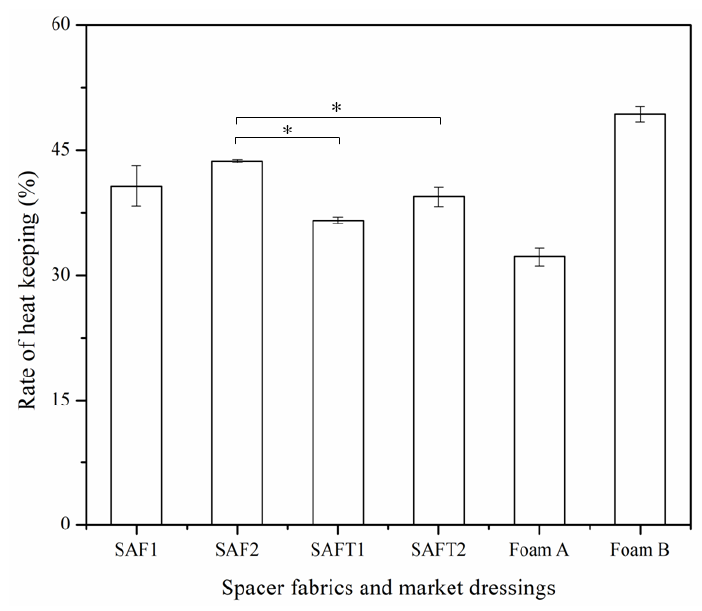
Figure 11. Rate of heat keeping of spacer fabrics and foam dressings from the market. * p < 0.05.